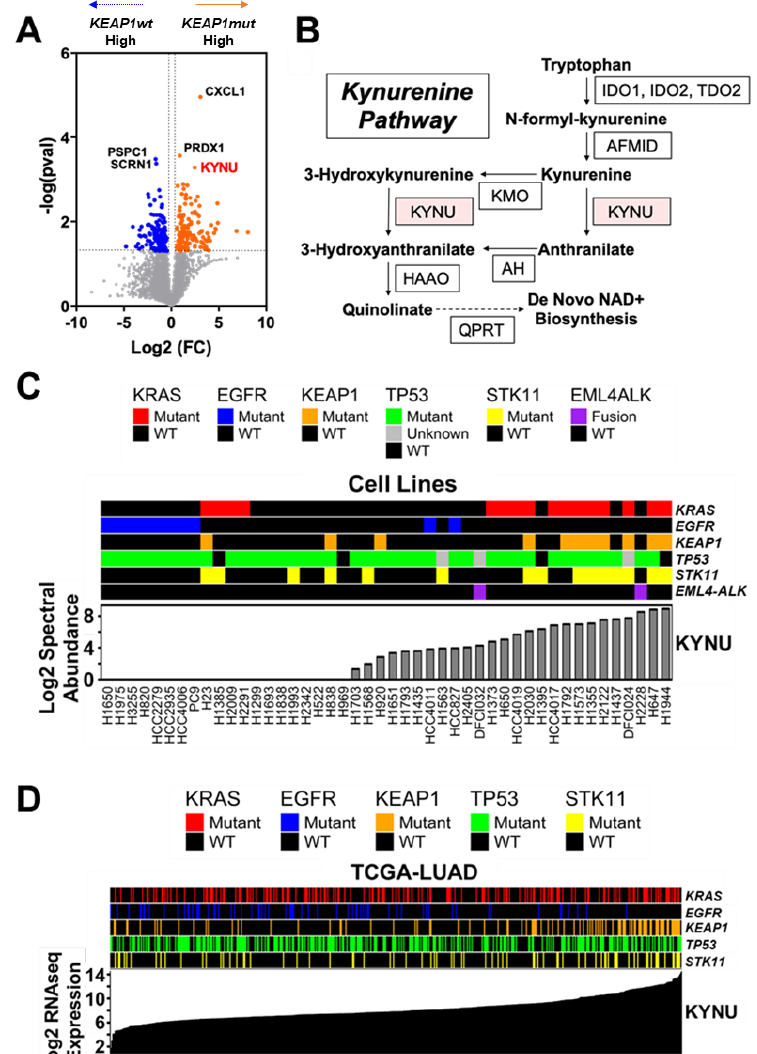
Figure 1. Lung Adenocarcinoma (LUAD) cell lines exhibit elevated KYNU expression. ( A ) Volcano plot illustrating differentially expressed proteins between KEAP1mt ( n = 11) and KEAP1wt ( n = 36) LUAD cell lines. Node color represent proteins that are statistically significantly (two-sided student t -test p < 0.05) increased (orange nodes) or decreased (blue nodes) in KEAP1mut LUAD cell lines. ( B ) Schematic of the kynurenine pathway (KP). ( C ) Association between whole cell lysate extract KYNU protein expression and presence of KRAS , EGFR , KEAP1 , TP53 , and STK11 mutations and EML4-ALK fusions amongst 47 LUAD cell lines. KYNU expression is ranked from lowest to highest. ( D ) Association between KYNU mRNA expression and presence of KRAS , EGFR , KEAP1 , TP53 , and STK11 mutations in TCGA-LUAD. KYNU mRNA expression is ranked from lowest to highest. Ab-